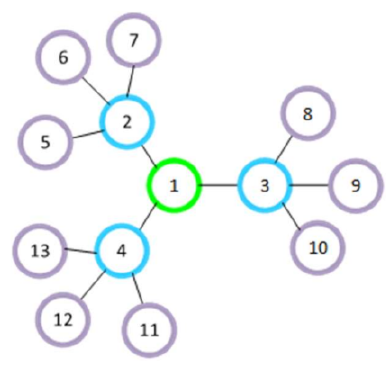
Figure A3. Topology where each mote has 3